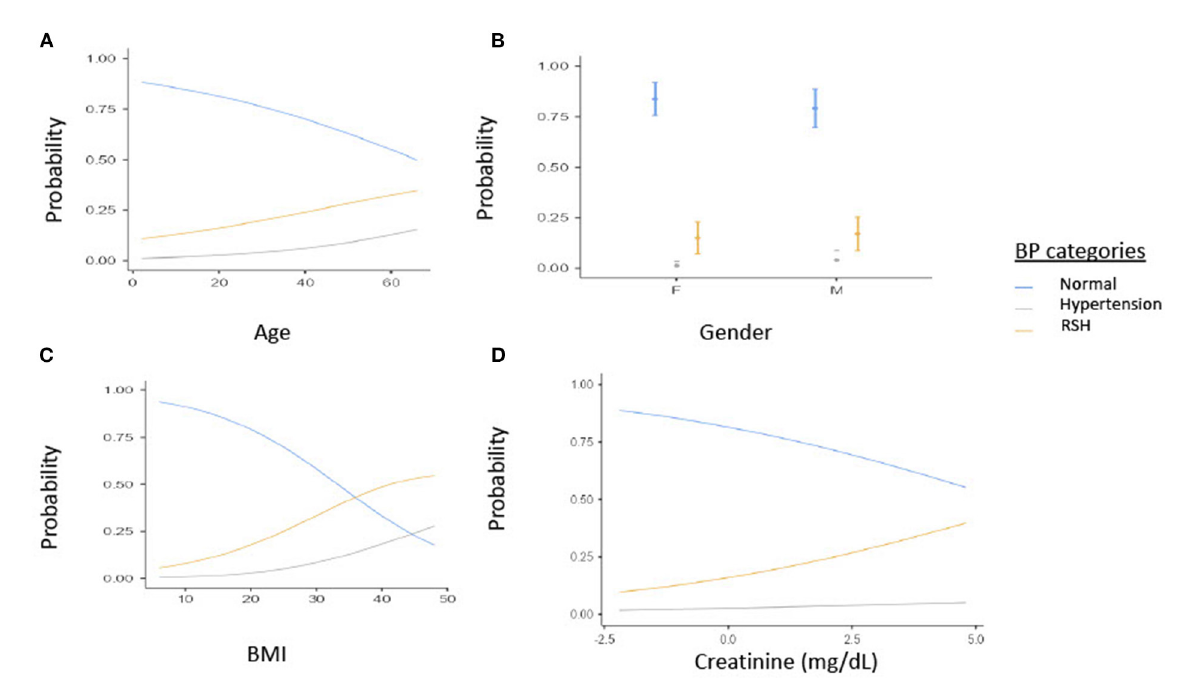
FIGURE1 Estimated marginal means of (A) Age, (B) Gender, (C) BMI by BP categories, (D) creatine (mg/dl). BP, Blood pressure; BMI, Body mass index; RSH, Relative systemic hypertension; F, Females; M,